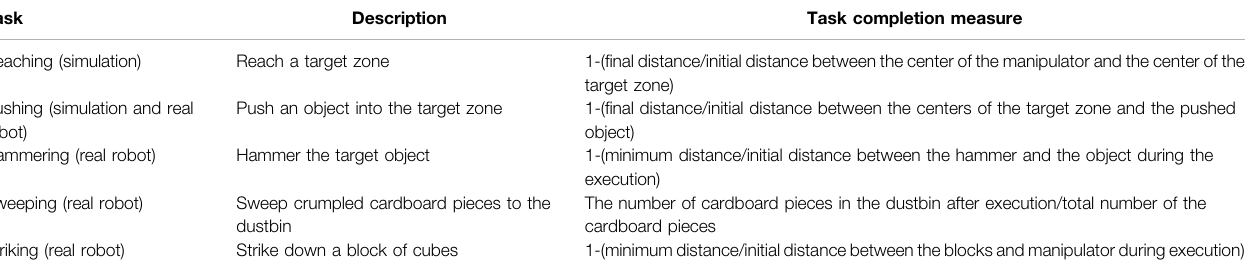
TABLE 5 | Task de fi nitions and completion measures.